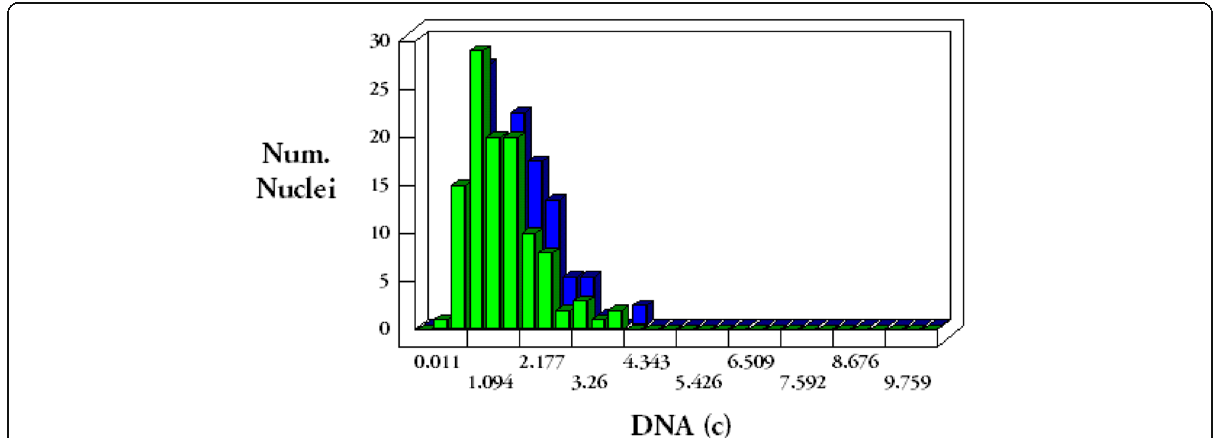
Fig. 2 Combo plot showing an overlap of irradiated and GABA-treated rat DNA histogram (green color) with the control rat histogram (blue